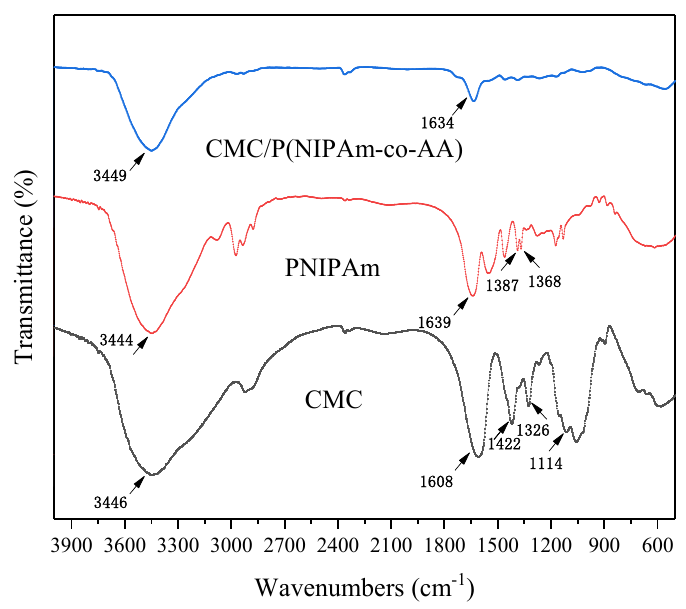
Figure 3. FTIR spectrum of CMC, PNIPAM, and CMC / P (NIPAM-co-AA).